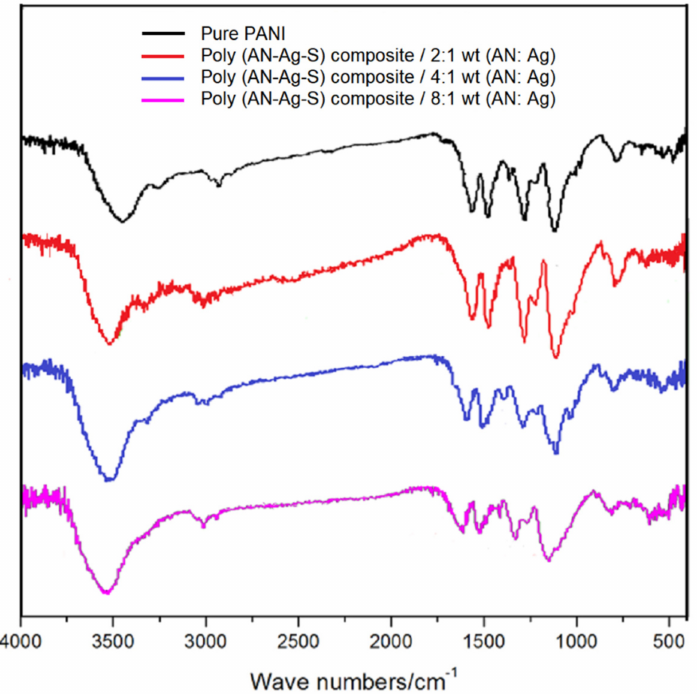
Figure 1. The Infrared Spectrum of pure PANI and poly (AN–Ag–S) composites with different Ag